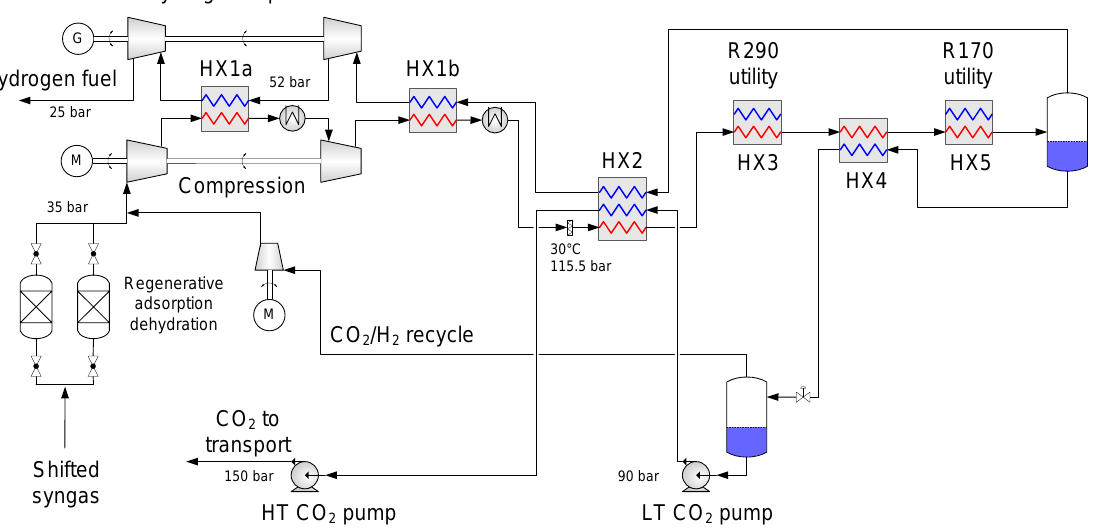
Figure 12. Process flow diagram with high-temperature expanders for improved operability.